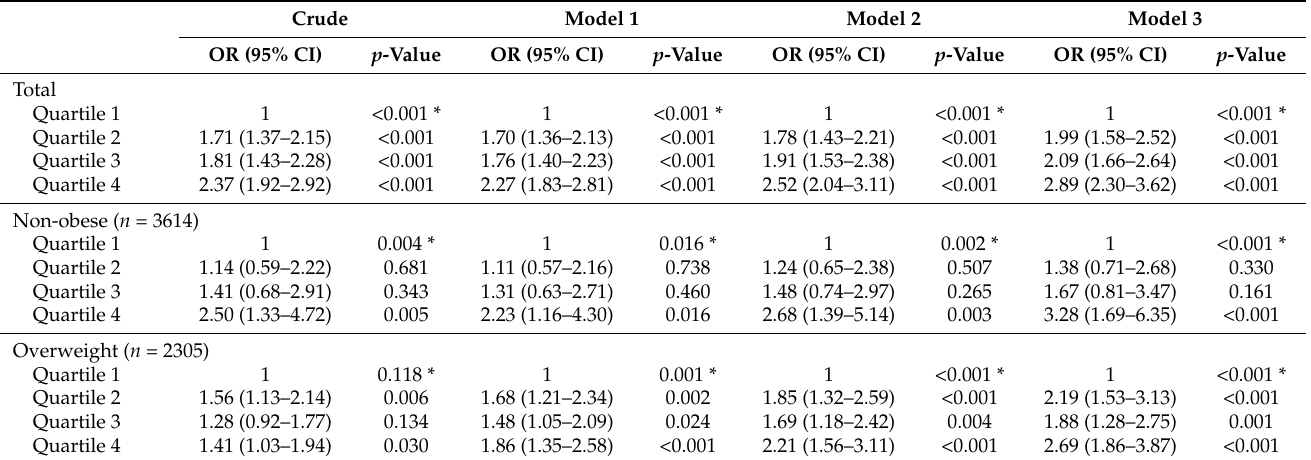
Table 4. Association between blood mercury levels and NAFLD.